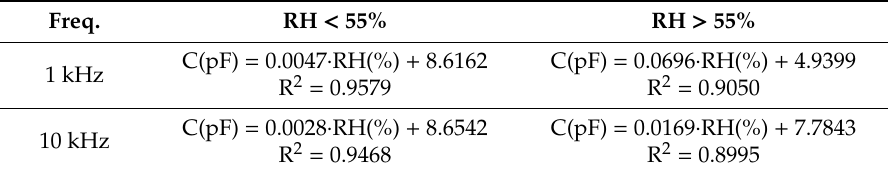
Table 1. Calibration curves extracted from Figure 4